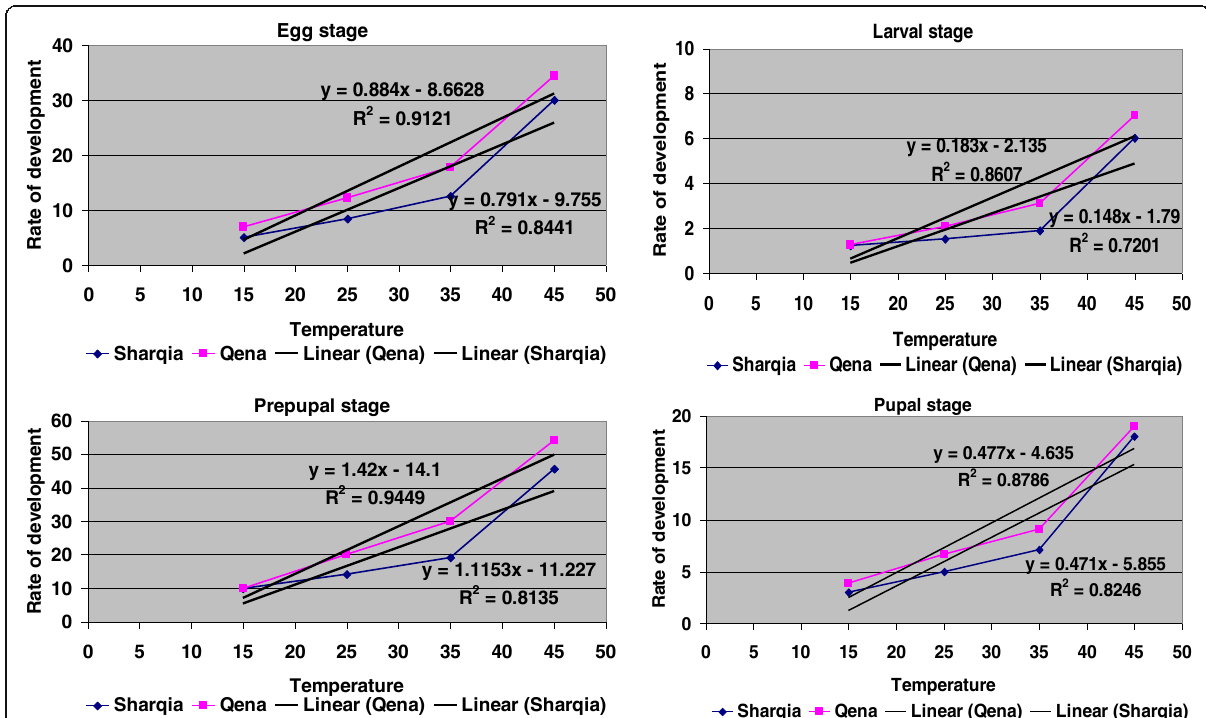
Fig. 1 Threshold temperature of different developmental stages of O. nubilalis